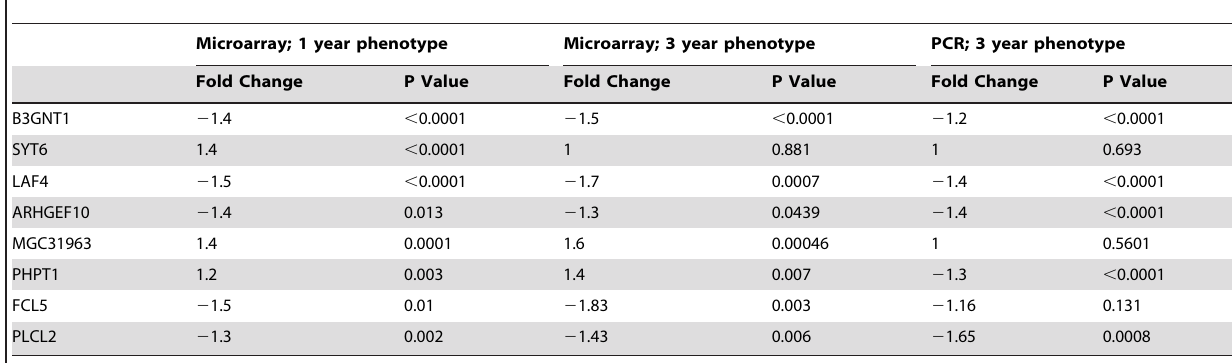
Table 4. Gene expression changes in the 6 gene panel identified by microarray analysis using the phenotype data after 1 year.